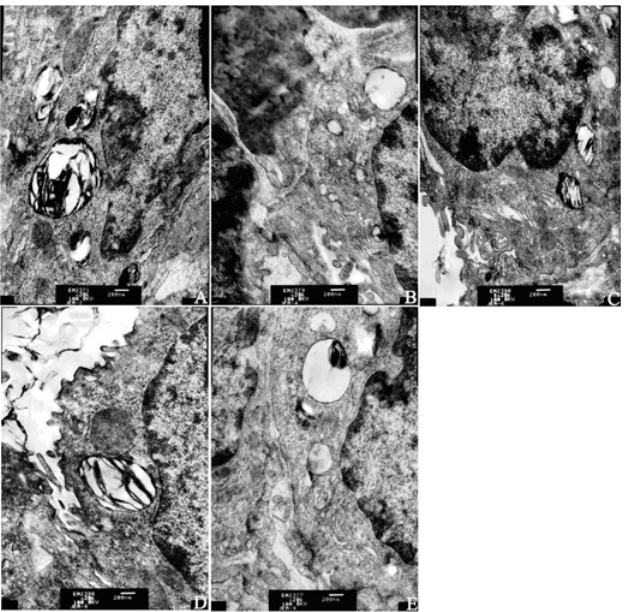
Figure 4. Ultrastructure of type-II alveolar epithelial cells in lung tissue (×20,000 magnification). A: Sham group; B: I/R group; C: IPO group; D: Levo group; E: Levo+5-HD group.